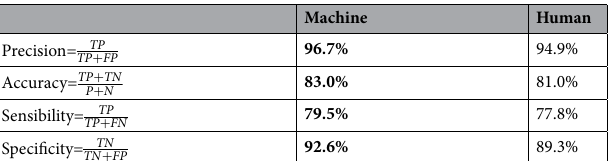
Table 2. Scraping algorithm performances vs. human annotation; best performances in bold. Machine performances always overcome human ones. From the data above, the primary human and machine problem seems to be missing the existing Twitter accounts (low sensibility). At the same time, if they find anything, they get the right one in most cases (high precision). The high specificity tells us that both the human and the machine can spot when the Twitter account is absent.